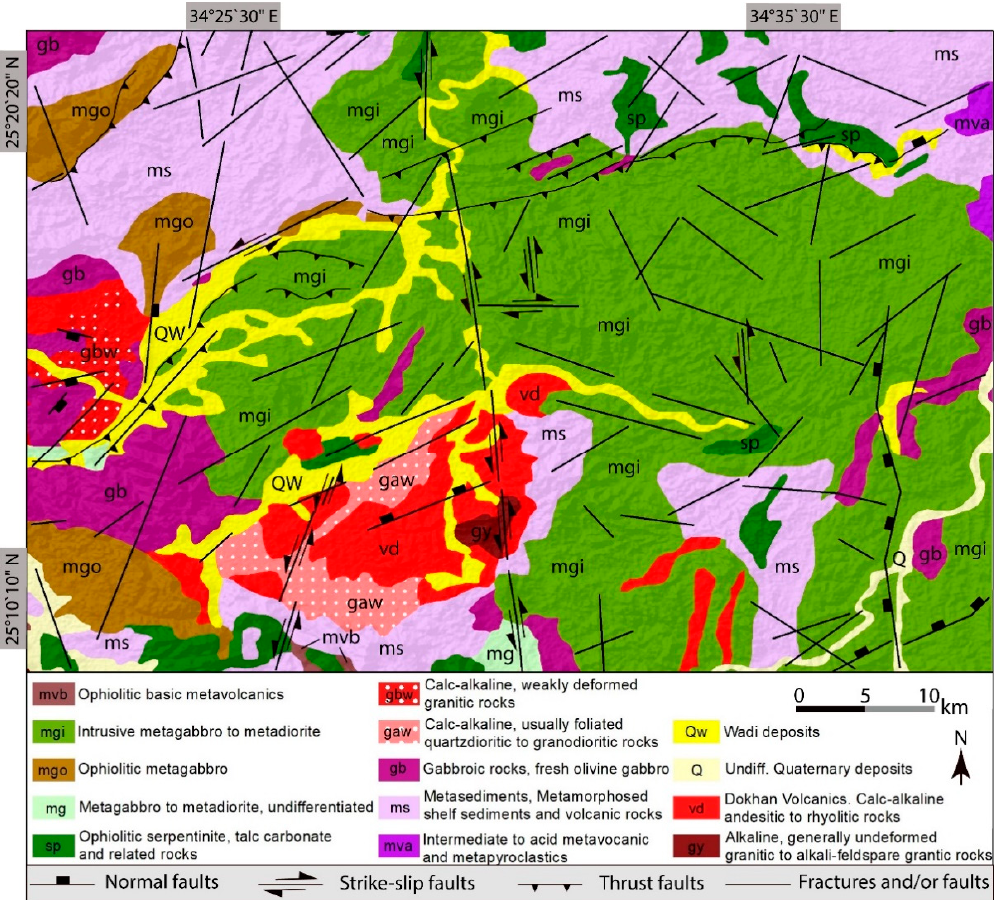
Figure 2. Geological map of the study area, modified after [25,45].